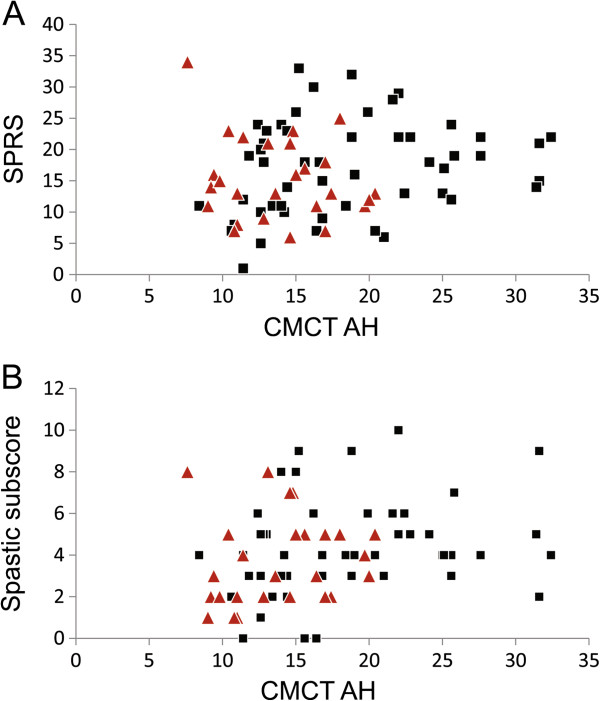
Conduction in motor evoked potentials correlate with clinical disease severity. In (A) Spastic Paraplegia Rating Scale (SPRS) [17], in (B) spastic subscore is correlated with central motor conduction time (CMCT) to the right abductor hallucis muscle (AH) (SPRS: r = 0.176; p < 0.028. Spastic subscore: r = 0.241, p < 0.005). Patients with SPG4 mutations are indicated by red triangles, other patients by black squares. Results to the left leg correlated accordingly; data not shown.